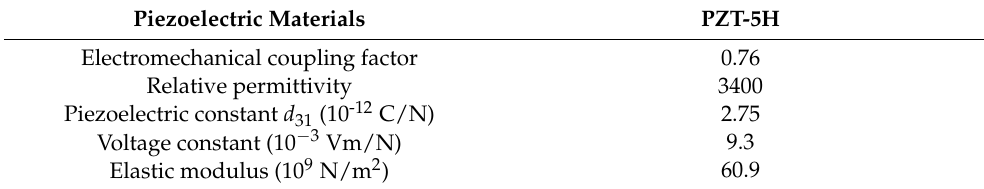
Table 1. Piezoelectric material performance